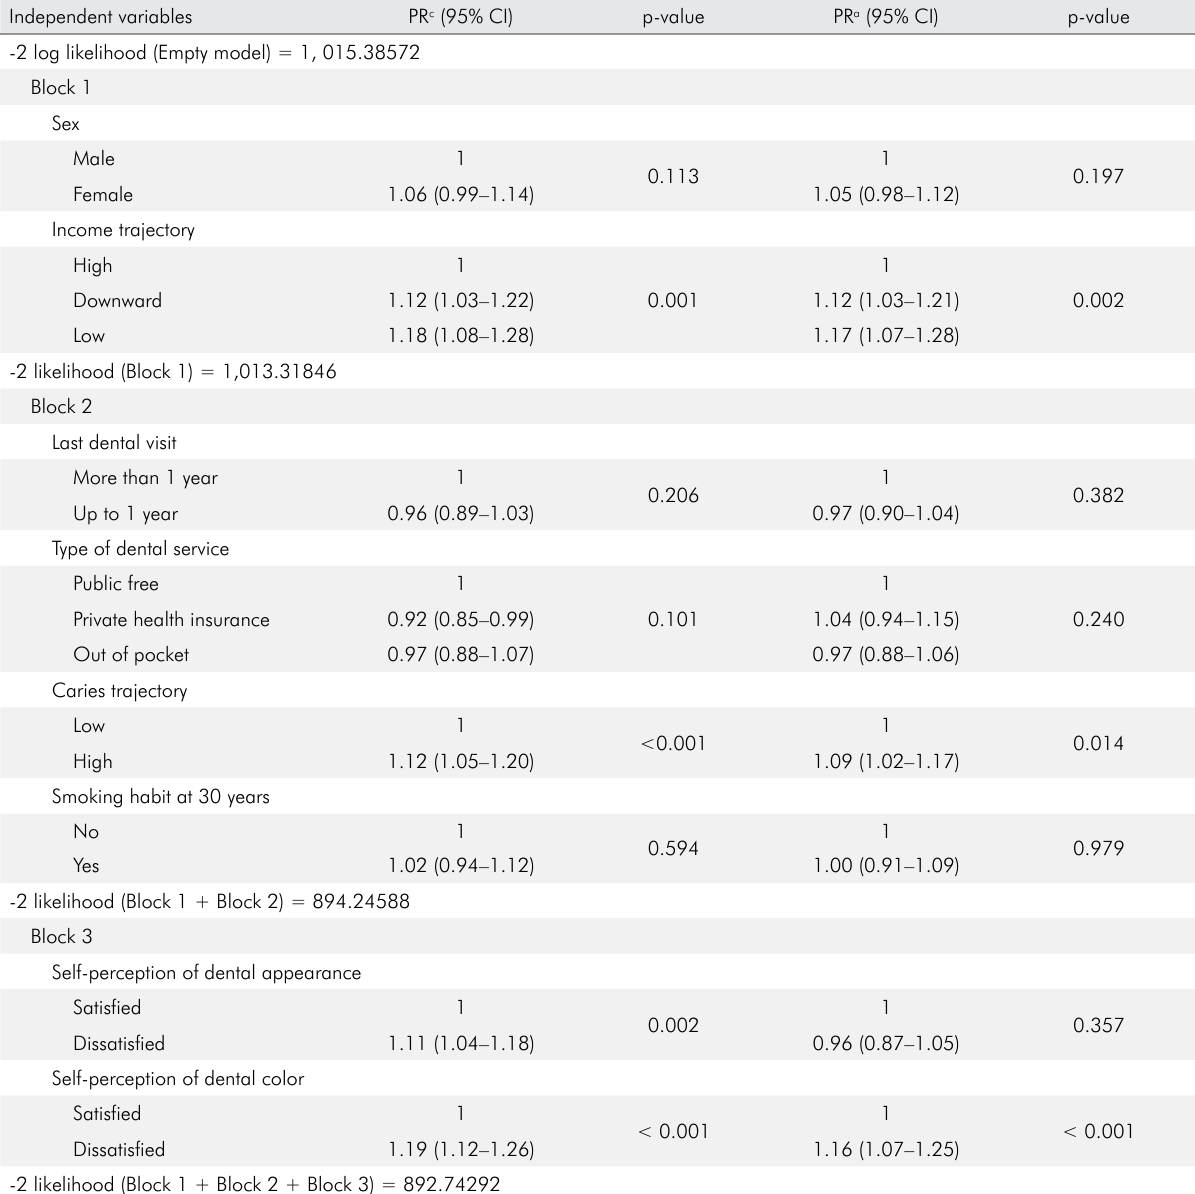
Table 3. Crude (c) and adjusted (a) prevalence ratios (PR) for factors associated with desire for tooth bleaching in individuals from 1982 Pelotas birth cohort (n = 536). Poisson regression analysis. Independent